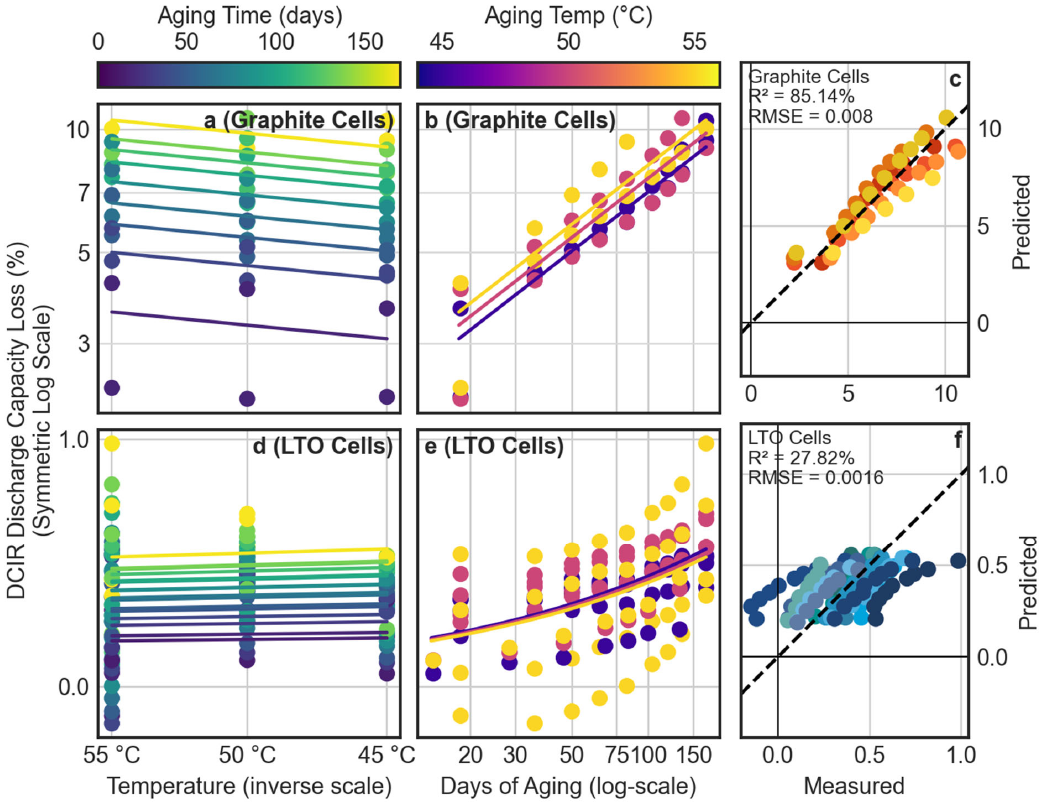
Figure A2. Quality of fit metrics for the modified Arrhenius fit of the DCIR cycle discharge capacity. Upper plots ( a – c ): the graphite cells. Lower plots ( d – f ): the LTO cells. Left column ( a , d ): capacity loss (symmetric log scale) vs. aging temperature (plotted on an inverse absolute temperature scale), with colors indicating aging time. Middle column ( b , e ): capacity loss vs. aging time, with colors indicating the aging temperature. Points indicate the measured data, lines reflect the best fit for the model. Right column ( c , f ): predicted vs. actual figures. Colors reflect individual cells; the 45° line indicates a perfect agreement between the model and the data.